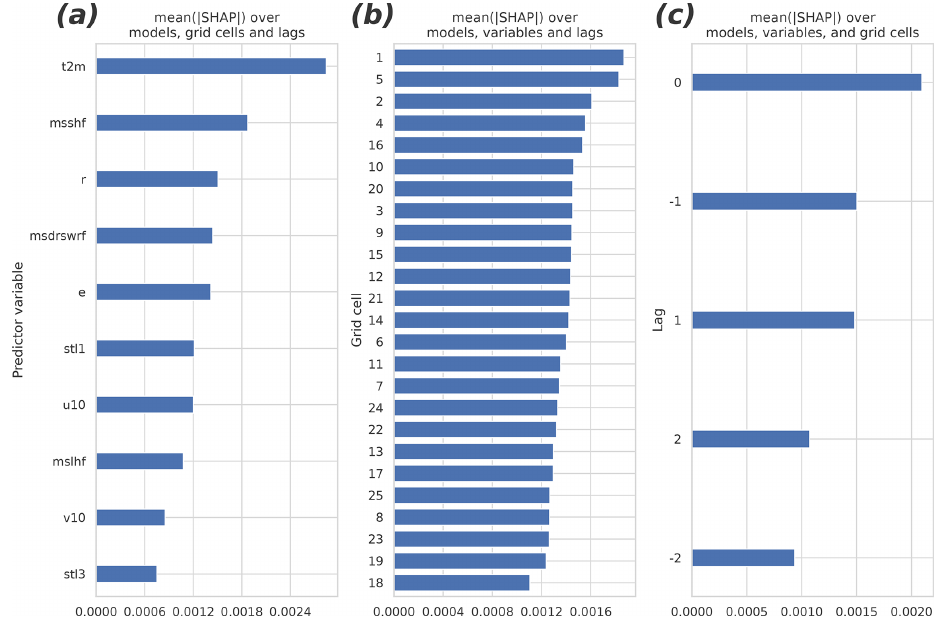
Figure 6. The mean absolute SHAP values separated by (a) the predictor variable, (b) the grid cell, and (c) the temporal lag. The higher the value, the more important the predictor/cell/lag. The redundant predictors, shown in Table 1, were excluded from the analysis and from the final fit of the model. See Fig. 2 for the organization of the grid cells and temporal